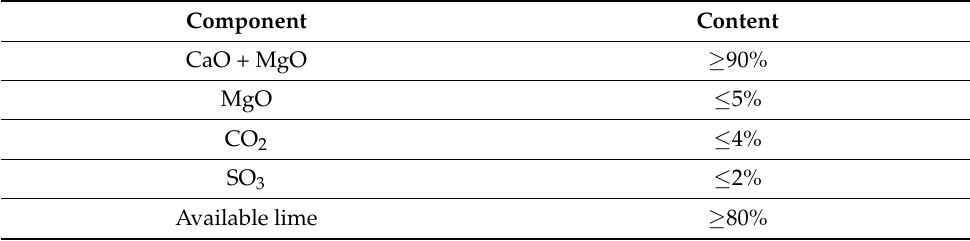
Table 5. Chemical characteristics of quicklime as a building material